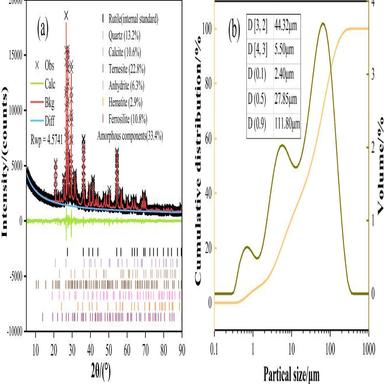
Characteristics of HPFA: (a)XRD refinement and quantitative analysis results of HPFA. (b) The particle size of HPFA. (c), (d)The SEM-EDS surface scanning results of HPFA.